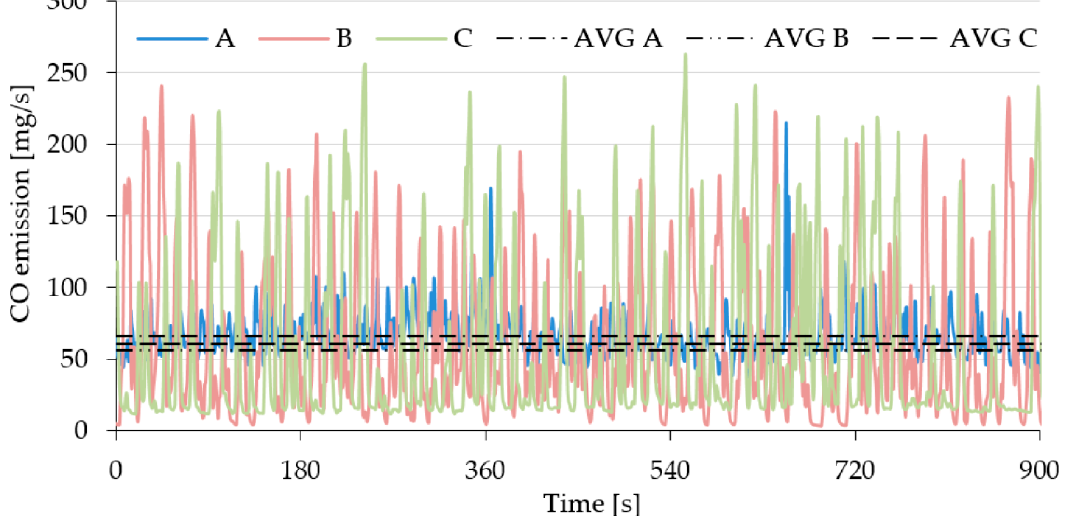
Figure 4. CO emission as a time function during the chipping process: A: Carburettor fuel supply system; B: Injector fuel supply system; C: Injector fuel supply system equipped with an adaptive drive control